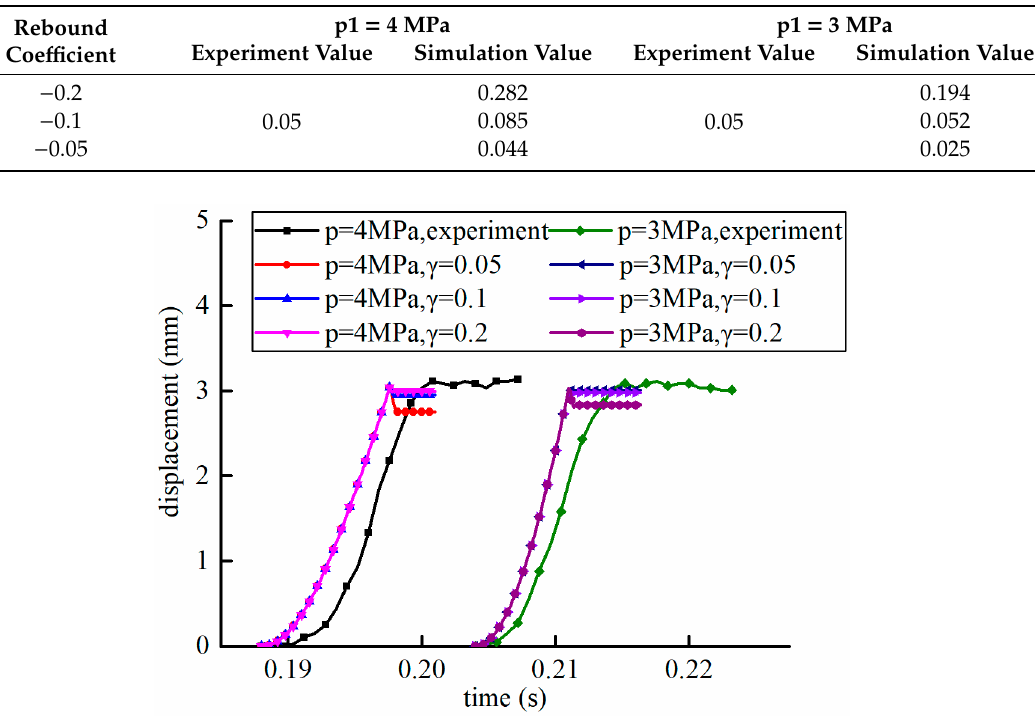
Figure 4. Movement curve of the actuator with different rebound coefficients and the same oil pressure.